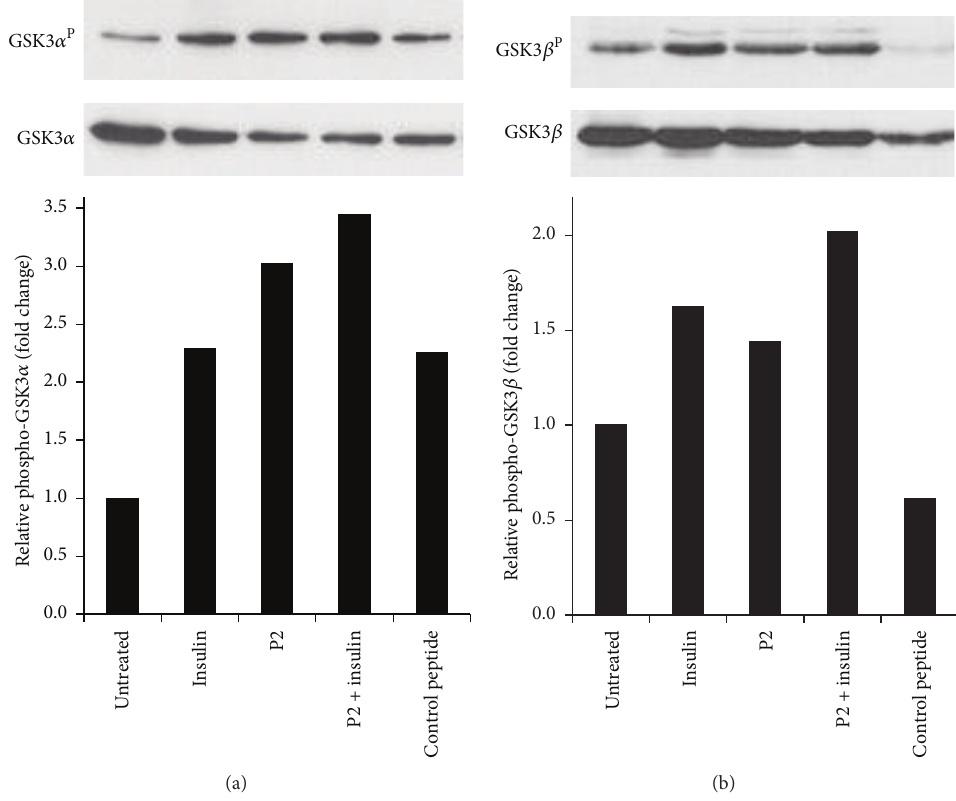
Figure 6: P2 inactivates GSK3. (a) Phosphorylation of GSK3 𝛼 in P2-stimulated cells. Lysates of cells treated as in Figure 5(a) were analyzed by Western blot; the blot was probed sequentially with antibodies to phospho-GSK3 𝛼 -S 21 and GSK3 𝛼 . The signals were quantified by densitometry as in Figure 5. (b) Phosphorylation of GSK3 𝛽 in P2-stimulated cells . Identical samples to those in (a) were probed with anti- phospho-GSK3 𝛽 -S 9 antibody, followed by anti-GSK3 𝛽 ; signals were quantified as in